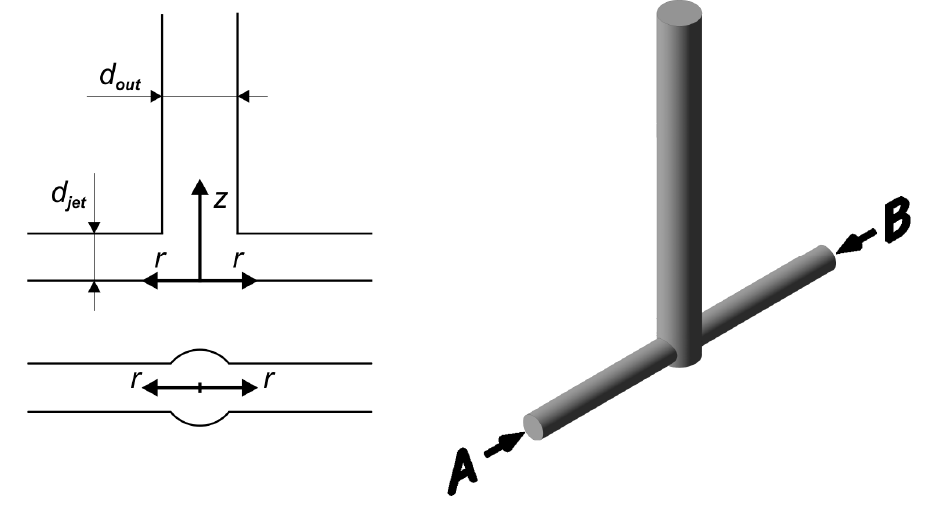
Processes 2020 , 8 , x FOR PEER REVIEW Figure 1. Geometry of a symmetric T-mixer (T-mixer). Figure 1. Geometry of a symmetric T-mixer (T-mixer).